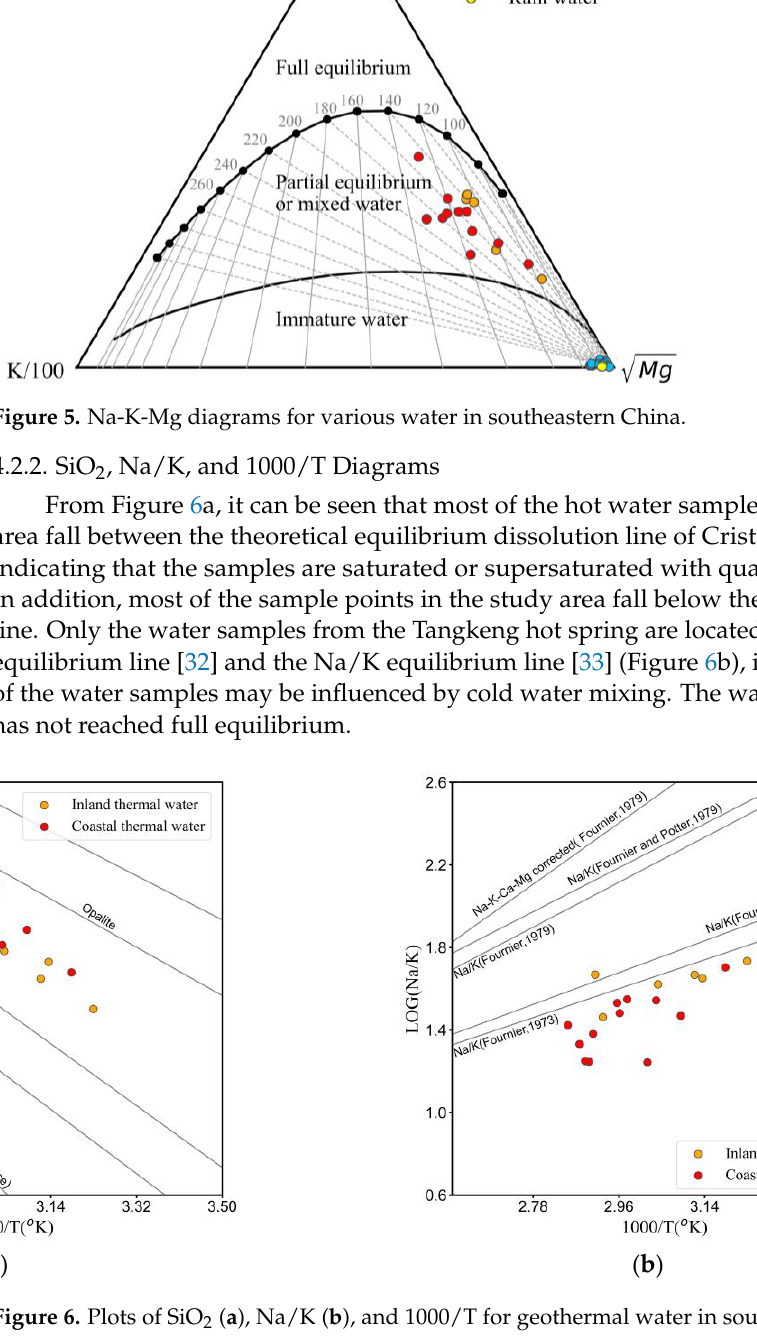
Table 2. Geothermal reservoir temperature for different geothermal systems in the study area by the SiO 2 geothermometer.